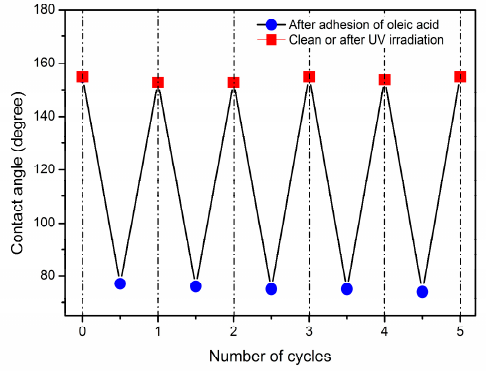
Figure 10. The water CA on TiO 2 -HBP / PU-6 nanocomposite coating in five cycles of oleic acid adhesion and UV